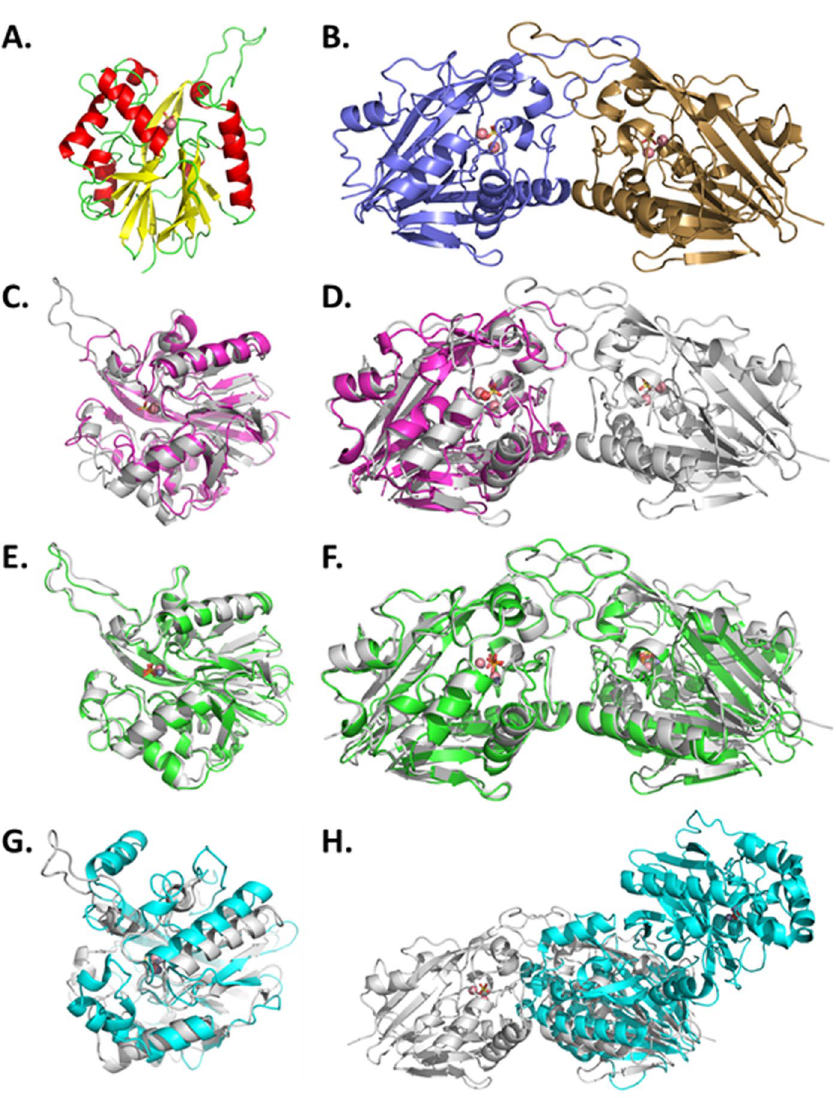
Figure 4. Structures of AaL and comparison to other known structures of MLLs. ( A ) AaL monomer shows a αβ / βα fold that contains two metal cations (pink spheres) and a bound phosphate anion (orange sticks). The α -helices, β -sheets and loops are represented in red, yellow and green, respectively. ( B ) AaL dimer. Each monomer (in blue and gold) contains an active site with two cobalt cations (pink spheres) bound to a phosphate anion (orange sticks). ( C ) Comparison of AaL (grey) and AiiA (pink) monomers. ( D ) Superposition of AaL dimer (grey) with the AiiA (pink) monomer. ( E ) Superposition of the monomers AaL (grey) and AiiB (green). ( F ) Comparison of the dimers of AaL (grey) and AiiB (green). The two enzymes show a similar dimerization mode. ( G ) Superposition of the monomer of AaL (grey) and AidC (cyan). ( H ) Superposition of AaL (grey) and AidC (cyan) dimers reveals their use of a different dimerization